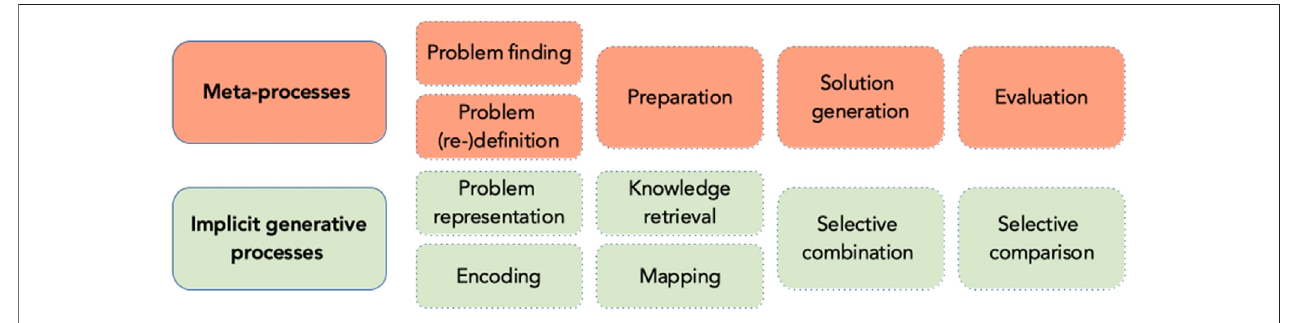
FIGURE 2 | Two-level view of the creative